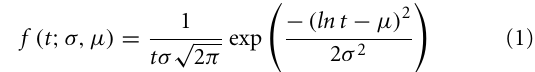
FIGURE 1 | Whole cell recording at multiple firing levels. (A) Raw intracellular recording illustrating the spikes of a spinal interneuron recorded at rest and with two higher firing levels obtained through current injection (200pA and 400pA, respectively). (B) Frequency distribution histogram (5ms bin width) of ISIs obtained by injections of 200pA. The ISIs of all current injections at this level was pooled to construct the histogram. Also indicated is the log-normal distribution that provided the best fit for the ISI distribution at this firing level. (C) As in (B) , but for 400pA injected current. In (B,C) , the p -value is given by the AD test, and indicates whether the null hypothesis that the ISIs originate from the log-normal distributions can be rejected or not. Since they are well above any confidence limit the found lognormal distributions can be said to well describe the ISI distribution. (D) For comparison, an analysis of the crossings of an arbitrary threshold level in the spontaneous synaptic activity. Same neuron as in (A–C) , but slightly hyperpolarized to prevent spiking. The inset show a raw intracellular sweep (2nd order Butterworth high-pass filter with a cutoff frequency of 1Hz and a